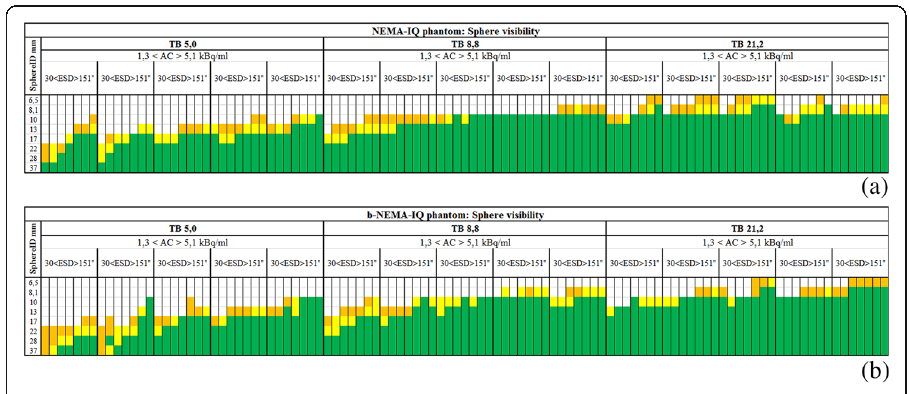
Fig. 5 Result of the visual detection of the spheres for NEMA-IQ ( a ) and b-NEMA-IQ ( b ) phantoms for different TBR, AC and ESD and sphere ID, in terms of median scores of the two observers: white [0 – 2.0], orange [2.0 – 2.7], yellow [2.7 – 3.4] and green [3.4 –